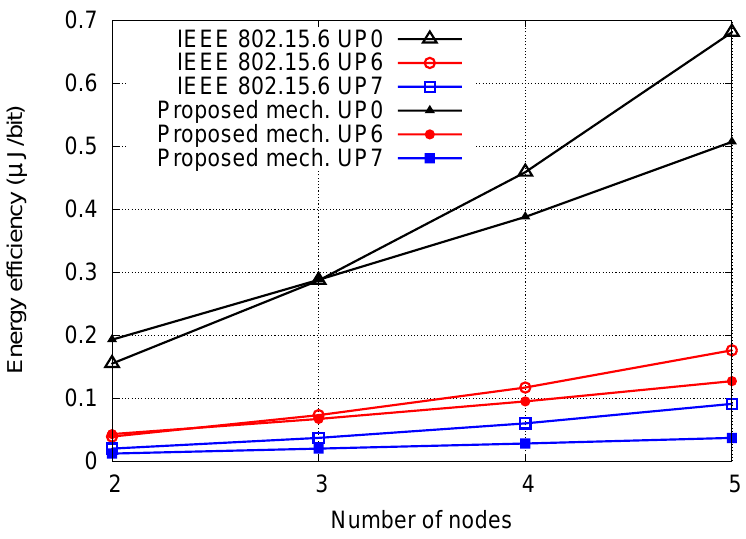
Figure 5. Energy efficiency comparison of IEEE 802.15.6 and proposed mechanism for different UP.